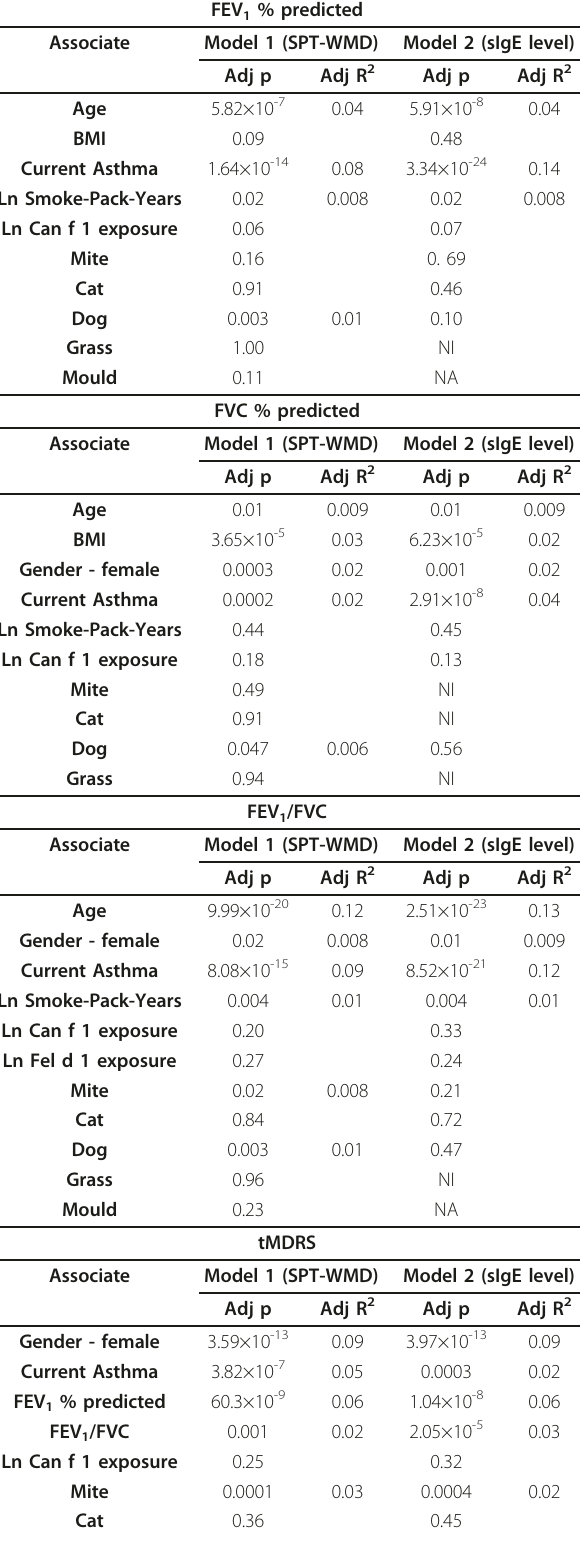
Table 7 Independent associates of lung function and AHR (multivariate analysis)